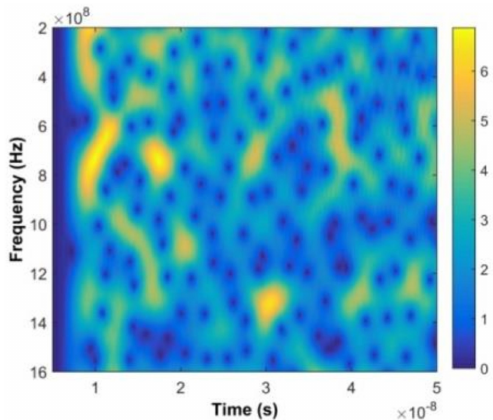
Figure 6. The time-frequency matrix without a test subject after the DWFT.